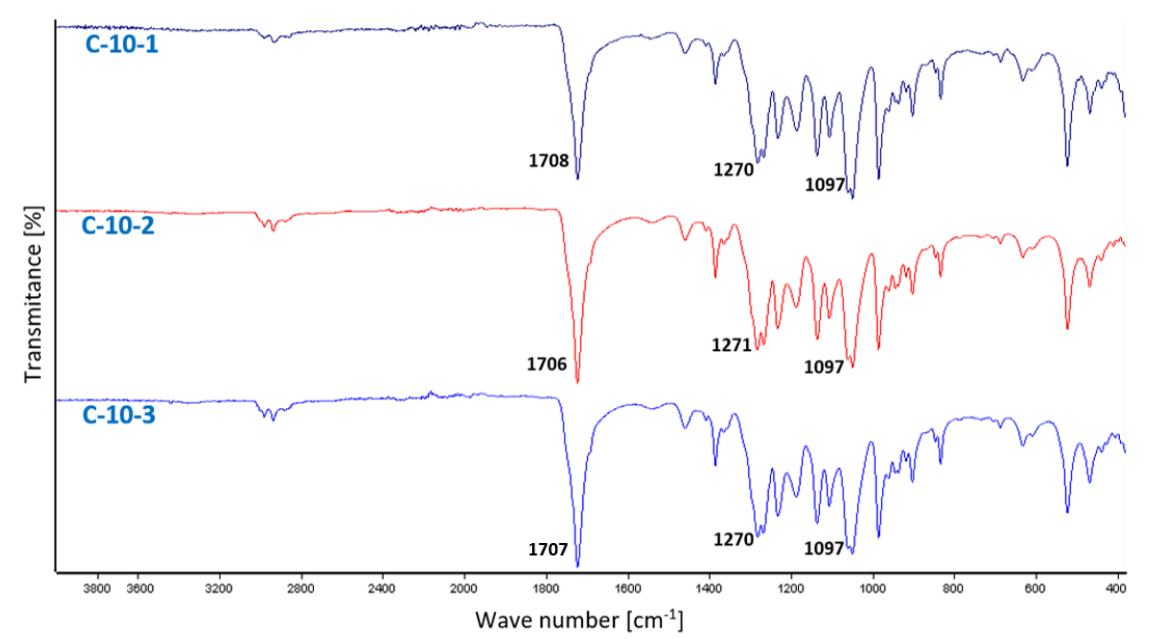
Figure 9. FTIR spectra of hybrid nanobiocomposites based on P3HB containing 10 wt.% of polyurethane (PU400) and 1, 2, and 3 wt.% of Cloisite ® 30B designated as C-10-1, C-10-2, and C-10-3, respectively.